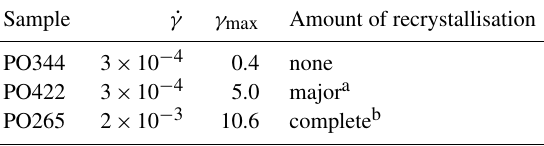
Table A1. Experimental samples revisited.